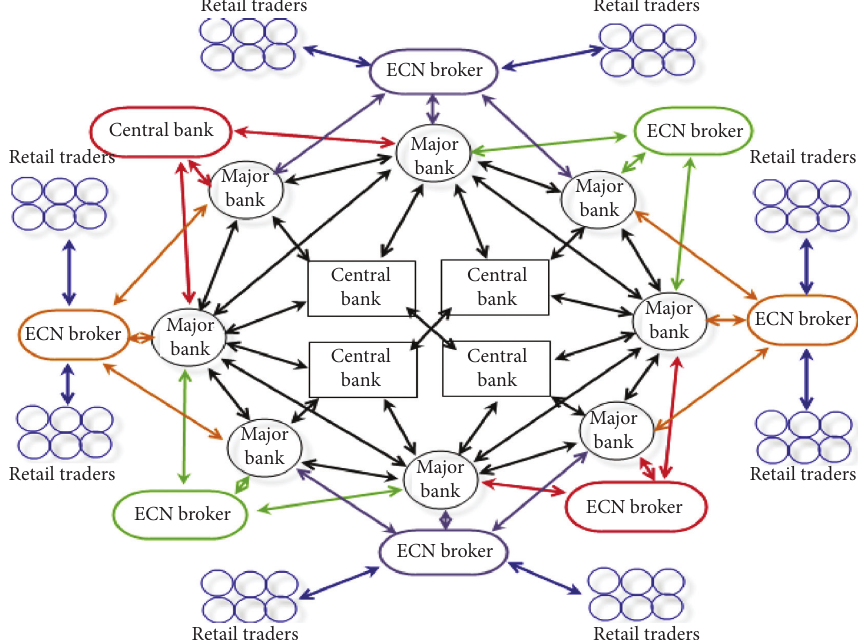
Figure 3: Schematic diagram of the foreign trade module